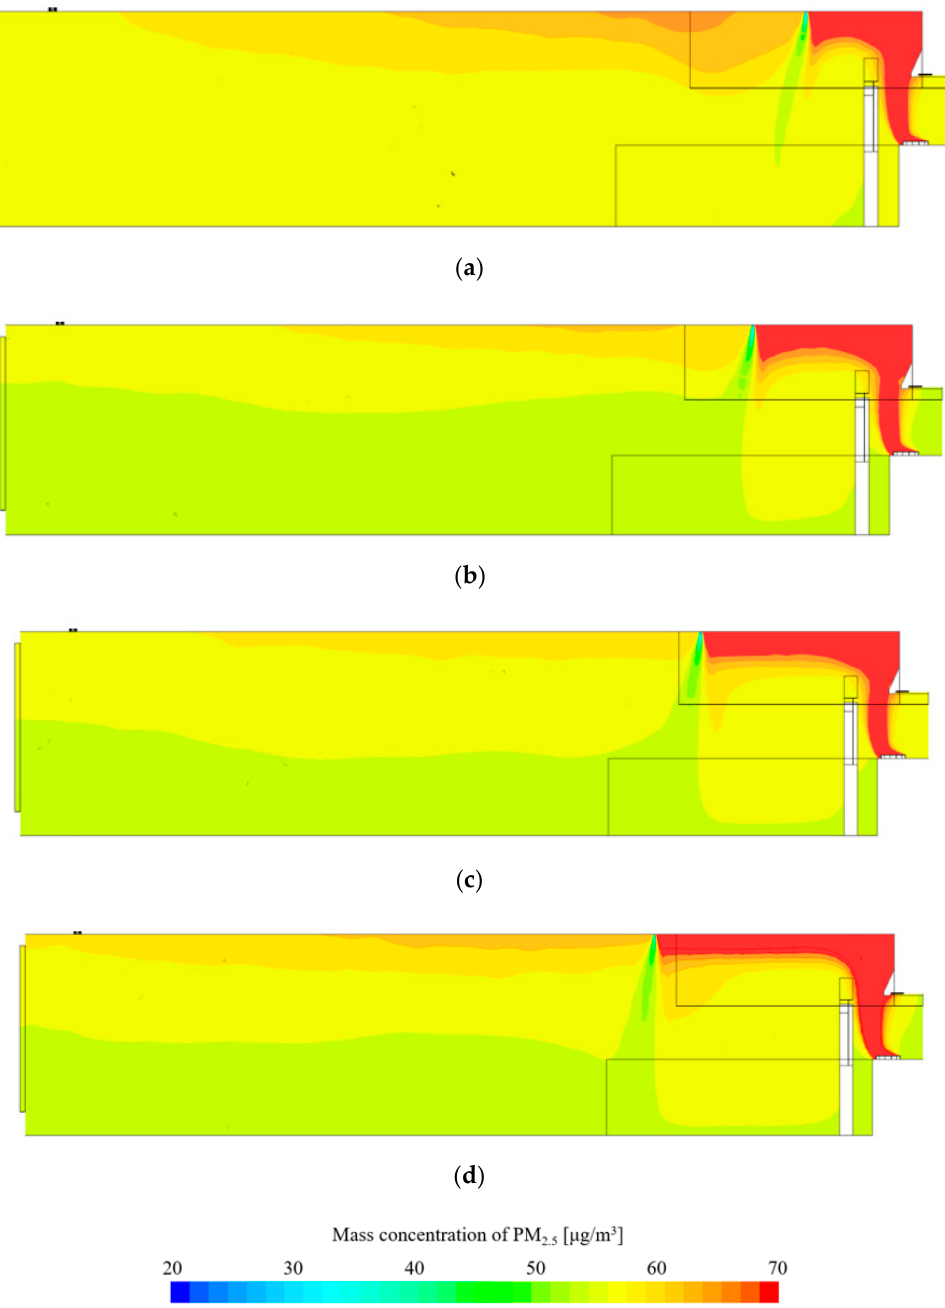
Figure 9. PM 2.5 concentration of vertical section. ( a ) Distance from the source: 1.0 m; ( b ) distance from the source: 1.5 m; ( c ) distance from the source: 2.0 m; ( d ) distance from the source: 2.5 m.